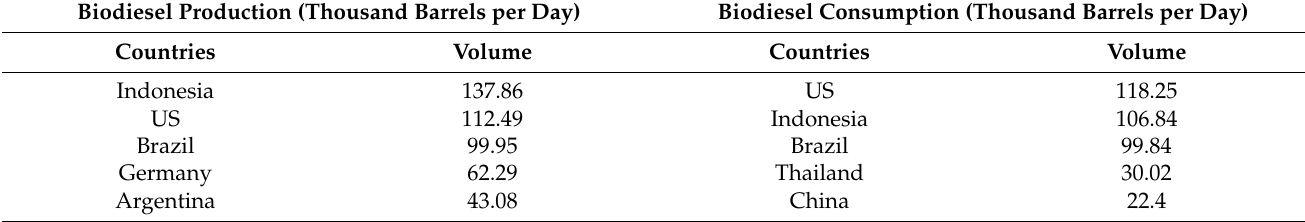
Table 6. Top five countries for biodiesel production and consumption in 2019 [146].